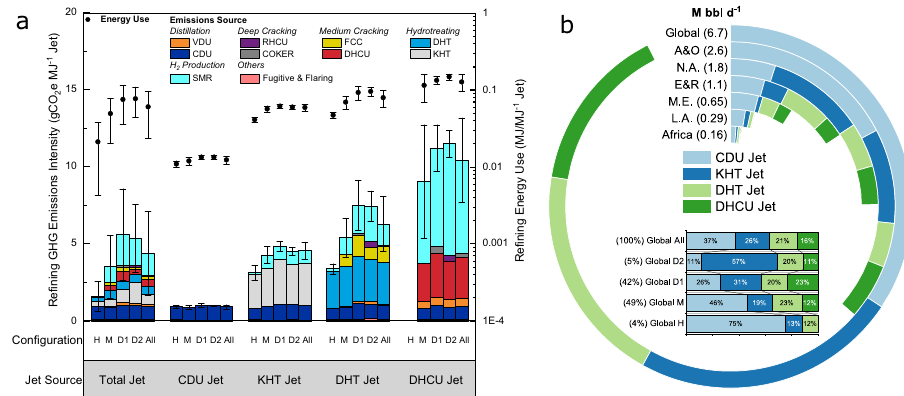
Fig. 3 | Jet fuel re fi ning CI breakdown and jet fuel composition. a Volume- weighted averagejet fuelre fi ning energyuse and CI breakdown by processunit, re fi nery con fi guration, and jet fuel source. Each stacked bar (breakdown by processunit)representsthevolume-weightedaverageCIofagivensourceofjet fuel produced by a speci fi c type of re fi nery con fi guration. Whiskers are volume- weighted average standard deviation. Energy use (secondary y-axis on a log scale)includeselectricity, steam,heat,hydrogen, andFCCcokeburn.Emissions from each process unit are calculated by converting the energy use (i.e., the portion allocated to jet fuel) to GHG emissions using emissions factors adopted in PRELIM. SMR: steam methane reformer; RHCU: residual hydrocracking unit; FCC: fl uid catalytic cracking unit; DHT: diesel hydrotreater; DHCU distillate hydrocracking unit; KHT: kerosene hydrotreater; VDU and CDU: vacuum and atmospheric distillation units, respectively. Con fi gurations H, M, D1, D2, and All